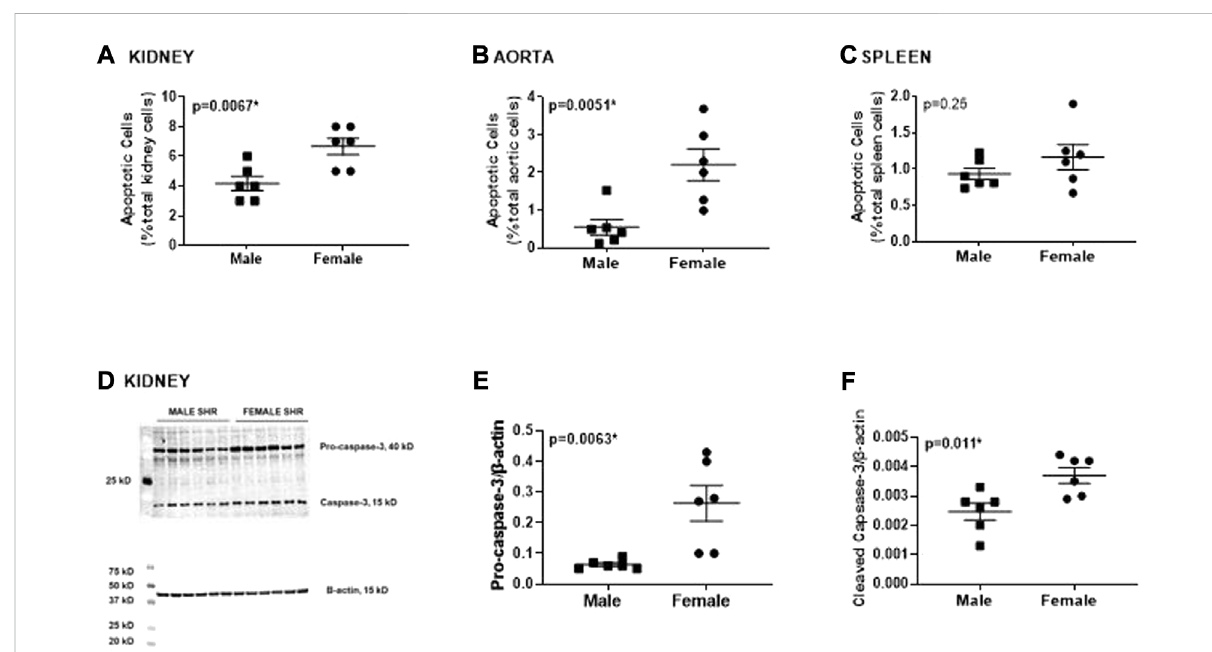
FIGURE 3 Female SHR have greater renal and aortic apoptosis compared to age matched males. Apoptotic cell death was measured by fl ow cytometric analysisandexpressedas%oftotalgatedcellsinwholekidney[panel (A) ],thoracicaorta[panel (B) ]andspleen[panel (C) ]from13 weekoldmaleand female spontaneously hypertensive rats (SHR; n = 6). Protein expression of renal caspase-3 (pro and active) was measured by Western blotting. Representative blots are in panel (D) with mean data in panels (E,F) . Data were compared using unpaired student-t